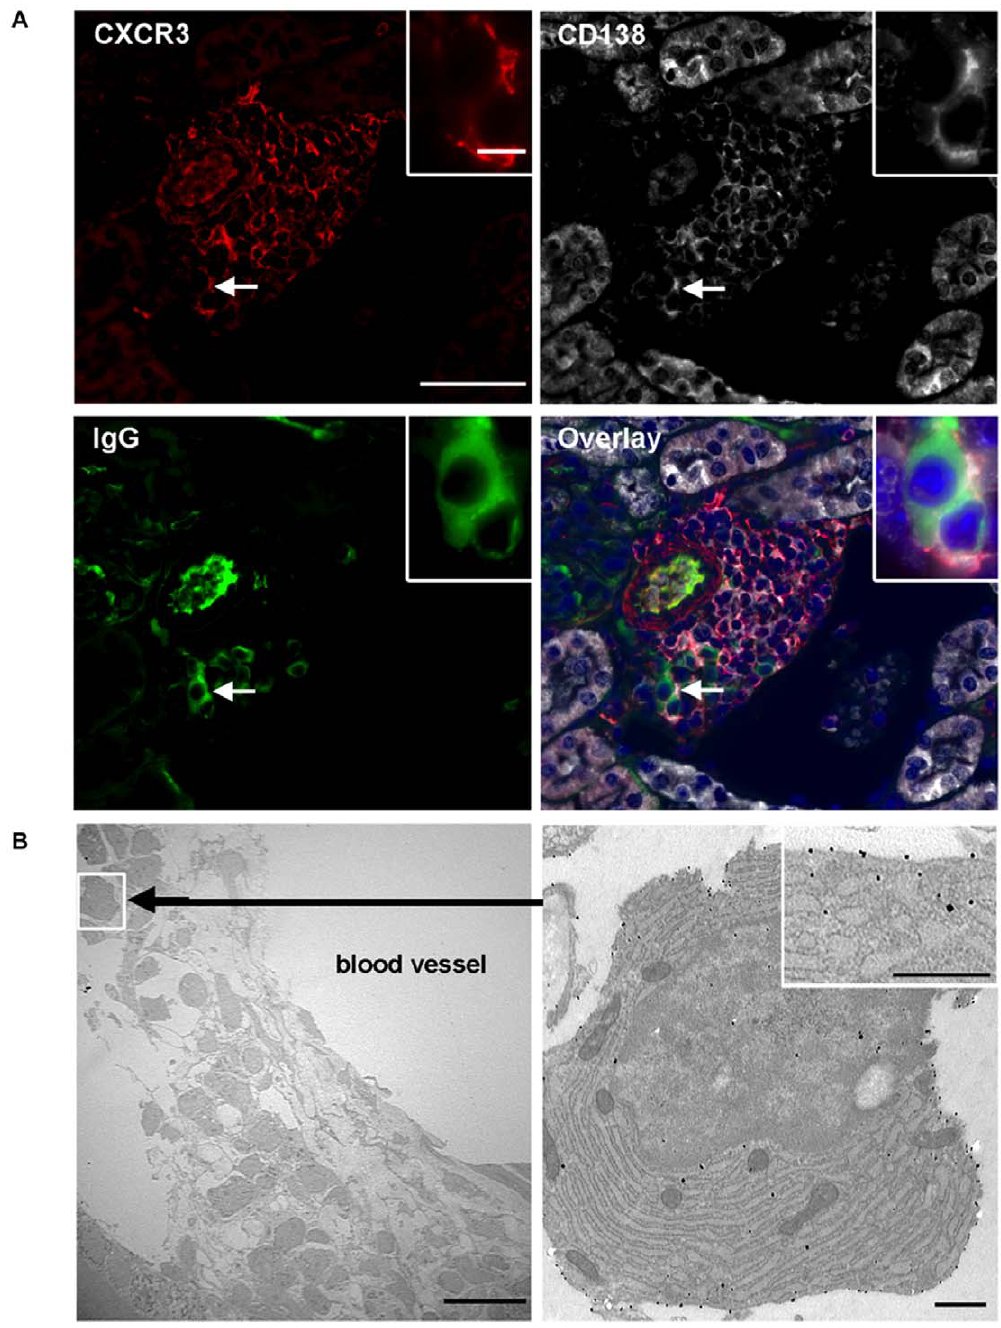
Figure 6. CXCR3 + CD138 + IgG + plasma cells are located in inflamed kidneys. A) IgG-producing CXCR3-expressing CD138 + cells were detected by immunofluorescence on paraffin-embedded kidney sections from proteinuria-positive NZB/W mice. Sections were labelled with CXCR3-specific (red), CD138-specific (white) and IgG-specific (green) Ab. Triple staining as well as nucleus DAPI staining (blue) are shown in the overlay picture. Scale bars: 50 m m (low magnification) or 10 m m (enlarged images). B) Cells showing the ultrastructural characteristics of plasma cells were visualized by transmission electron microscopy in the kidneys of nephritic NZB/W mice. The right-side image shows that these endoplasmic reticulum-rich cells express CXCR3 (revealed by gold-labeled anti-CXCR3 Ab). Scale bars: 10 m m (left image) and 500 nm (right images). All images are representative and derived from kidneys of two to four NZB/W mice. doi:10.1371/journal.pone.0058140.g006 Indeed the molecular link between CXCR3 and IgG might be the although rather surprisingly IgG1 was found to be the preferential pro-inflammatory Th1 cytokine IFN c , known to induce expression CXCR3-associated isotype in human memory B cells [14]. In line of both CXCR3 and its ligands as well as to favor class switch with this result, CXCR3-deficient NZB/W mice were found to recombination towards IgG2a and IgG3 isotypes in mice, exhibit reduced production of total and anti-dsDNA Ab of the